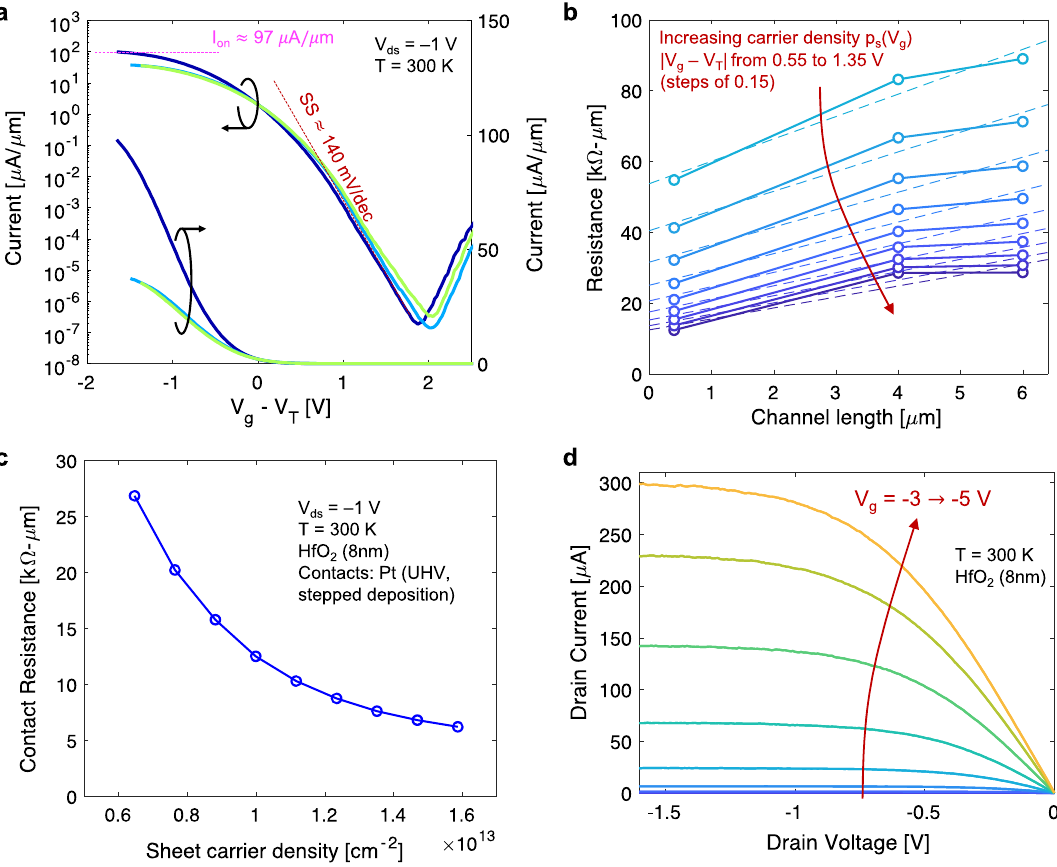
Figure 3. ( a ) Drain current (I d ) vs. gate voltage above threshold (V g –V T ) for WSe 2 PMOS FETs with different channel lengths (400 nm, 4 µm, 6 µm) measured at room temperature with drain-to-source voltage of V ds = – 1 V. These devices show a subthreshold swing of ~ 140 mV/dec and on-state current normalized to channel width (W) of about 97 µA/µm (b) Total resistance vs. channel length for increasing sheet carrier density (as labelled, measurements correspond to V g –V T ranging from – 0.55 V to – 1.35 V). ( c ) Contact resistance extracted from extrapolation to L = 0 as a function of channel sheet carrier density. ( d ) Drain current (I d ) vs. drain voltage (V d ) characteristics under different gate biasing conditions from subthreshold to strong inversion (V g in steps of – 0.25